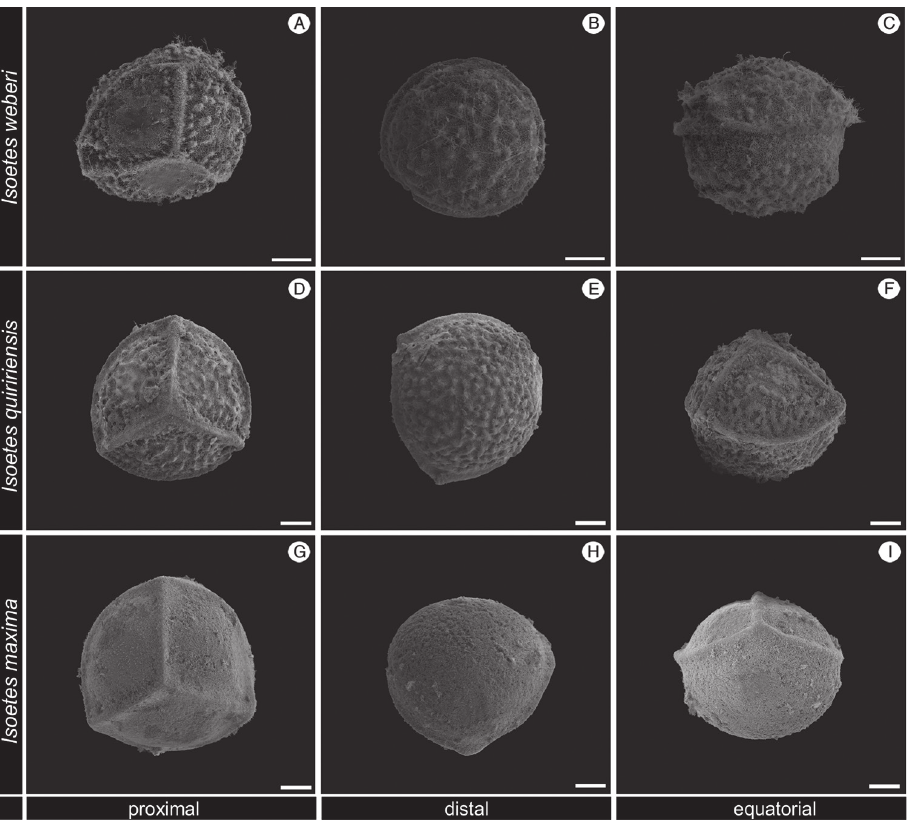
Figure 6. SEM images of the megaspore of Isoetes weberi (Herter 95840, US), I. quiririensis (Pereira 635, UPCB), I. maxima (Pereira 631, UPCB). A–C Megaspore of I. weberi A Proximal view B Distal view C Equatorial view D–F Megaspore of I. quiririensis D Proximal view E Distal view F Equatorial view G–I Megaspore of I. maxima J Proximal view K Distal view L Equatorial view. All scale bars = 100 µm. 3'